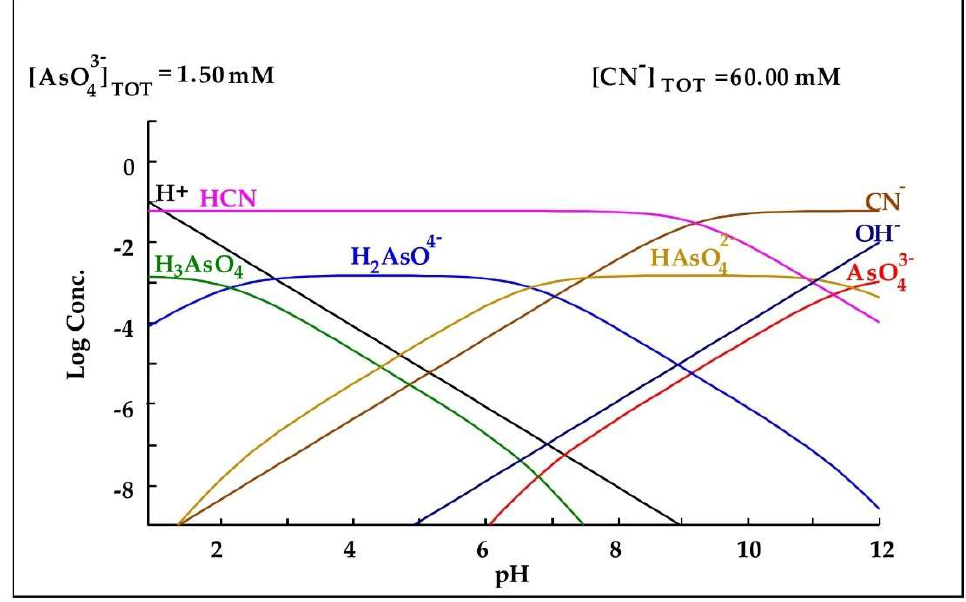
Figure 6. Diagram of distribution of species of the AsO 3 − -CN − system based on the concentrations present in the leaching medium. Diagram made by the authors in Medusa software version 2010.